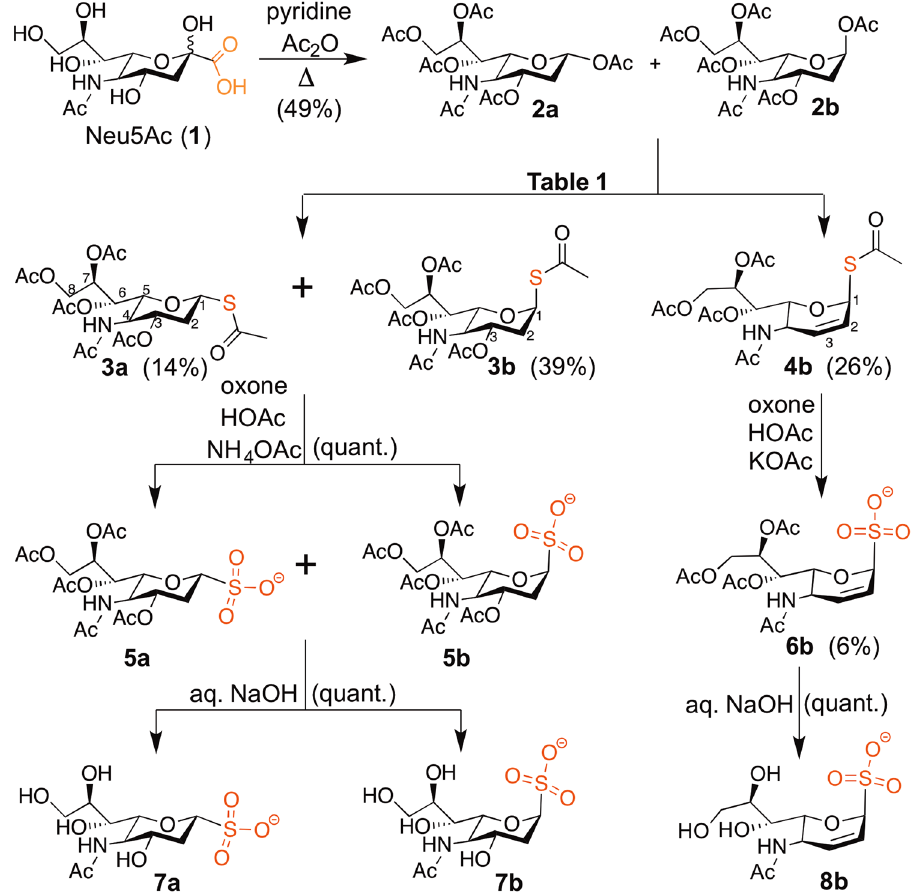
Figure 2. Synthesis of sulfo-sialic acid analogues. α -Anomers 2a , 3a , 5a and 7a are in the R anomeric configuration with equatorial anomeric functional groups, and β -anomers 2b , 3b , 4b , 5b , 6b , 7b and 8b are in the S anomeric configuration with axial anomeric functional groups.